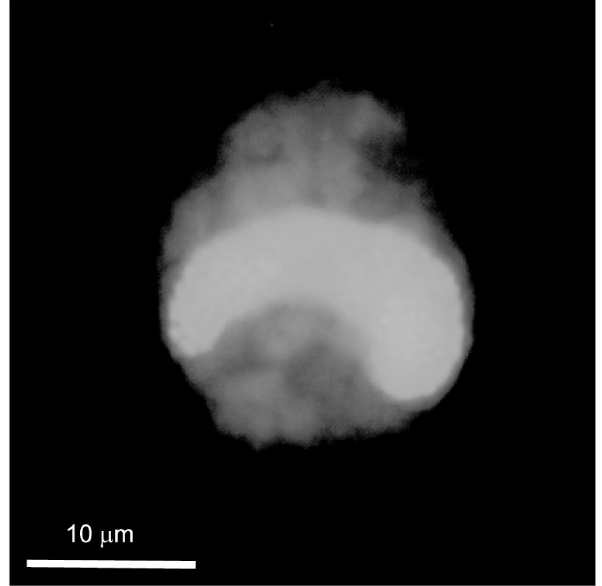
Figure 6. SYBR Green epifluorescence micrographs showing the U-shaped nucleus of NQAIF103. doi: